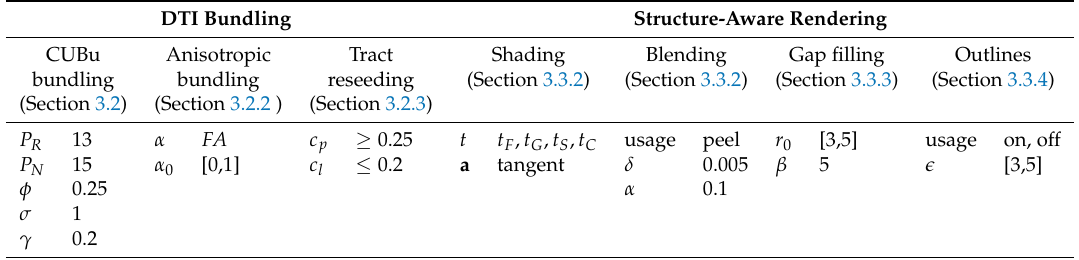
Table 3. Parameters of the end-to-end DTI bundling-and-rendering pipeline and their